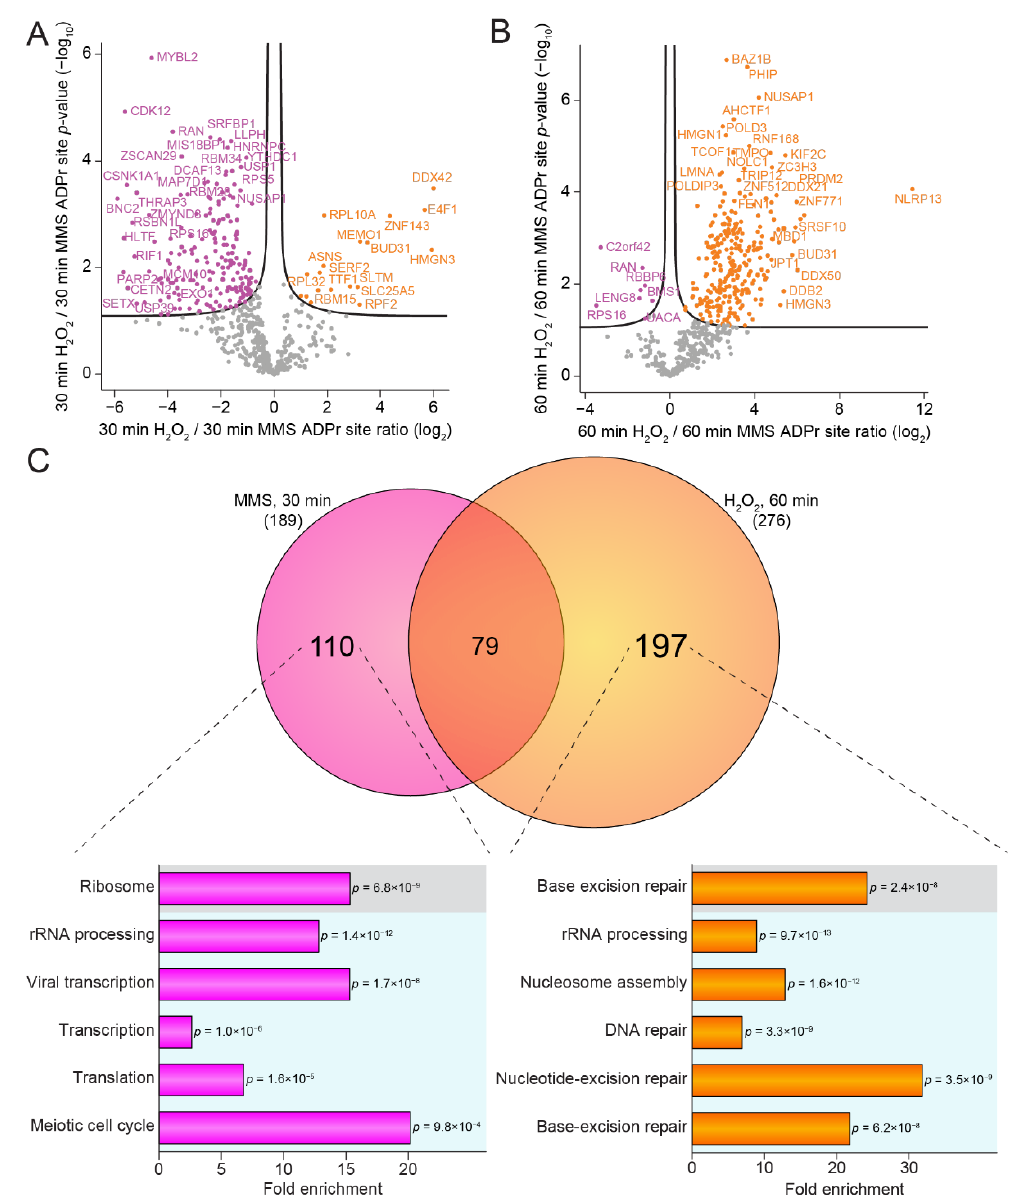
Figure 4. Temporal-specific changes in the ADP-ribosylome. ( A ) Volcano plot analysis visualizing the dynamics of ADPr target proteins after 30 min of H 2 O 2 treatment compared to 30 min of MMS treatment. Significance was determined via two-tailed Student’s t-testing, with an FDR of 0.05, an s0 of 0.1, and 2500 rounds of randomization. Proteins significantly upregulated by MMS treatment are depicted in pink, proteins significantly upregulated upon H 2 O 2 treatment are depicted in orange, and proteins not significantly regulated are shown in grey. ( B ) As A, but illustrating the changes after 60 min of treatment. ( C ) Scaled Venn diagram showing the overlap between proteins significantly upregulated upon 30 min of MMS treatment compared to proteins significantly upregulated upon 60 min of H 2 O 2 treatment (top panel). Gene ontology enrichments of the proteins specific for those upregulated upon 30 min MMS compared to the total genome (bottom, left panel) and of the proteins specific for those upregulated upon 60 min of H 2 O 2 compared to the total genome (bottom, right panel). Grey box: KEGG, blue box: GOBP.